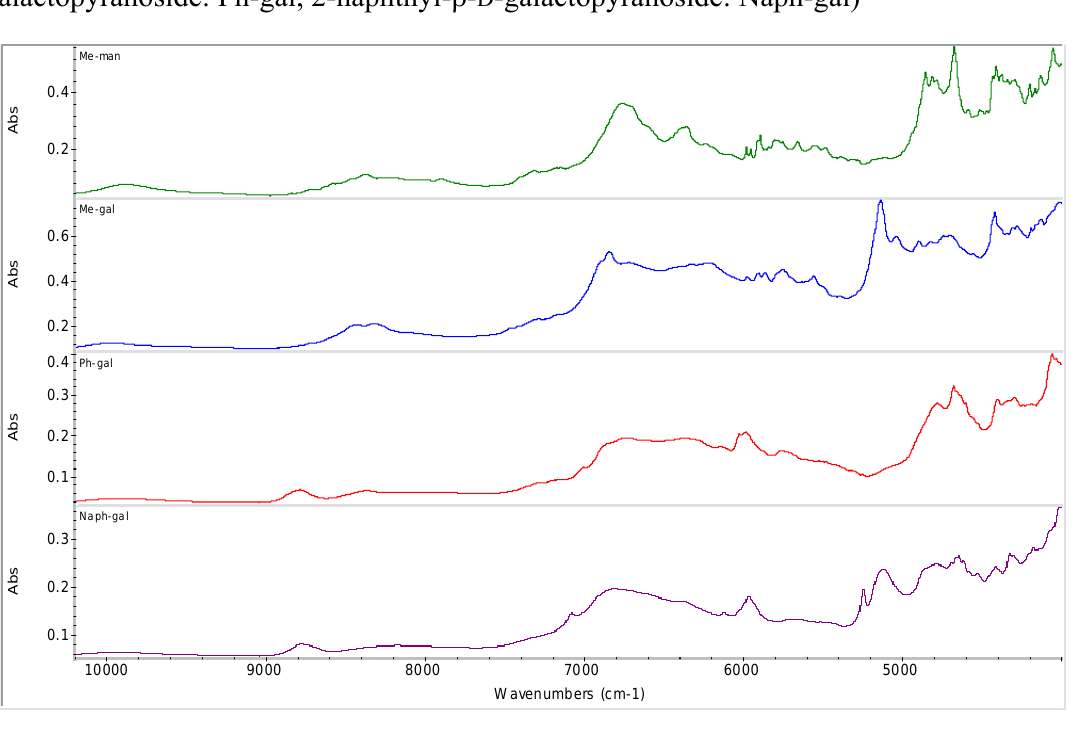
Figure 8. NIR spectra of D -manno- and D -galacopyranose derivatives. (methyl- α - D - mannopyranoside: Me-man, methyl- β - D -galactopyranoside: Me-gal, phenyl- β - D - galactopyranoside: Ph-gal, 2-naphthyl- β - D -galactopyranoside: Naph-gal)